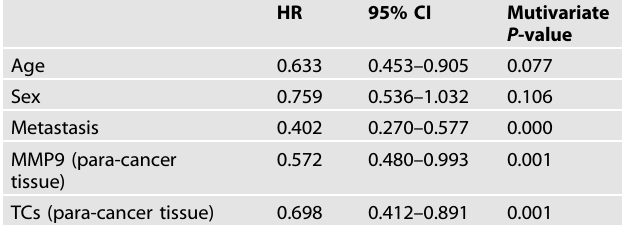
Table 3. Multivariate analysis of overall survival in HCC